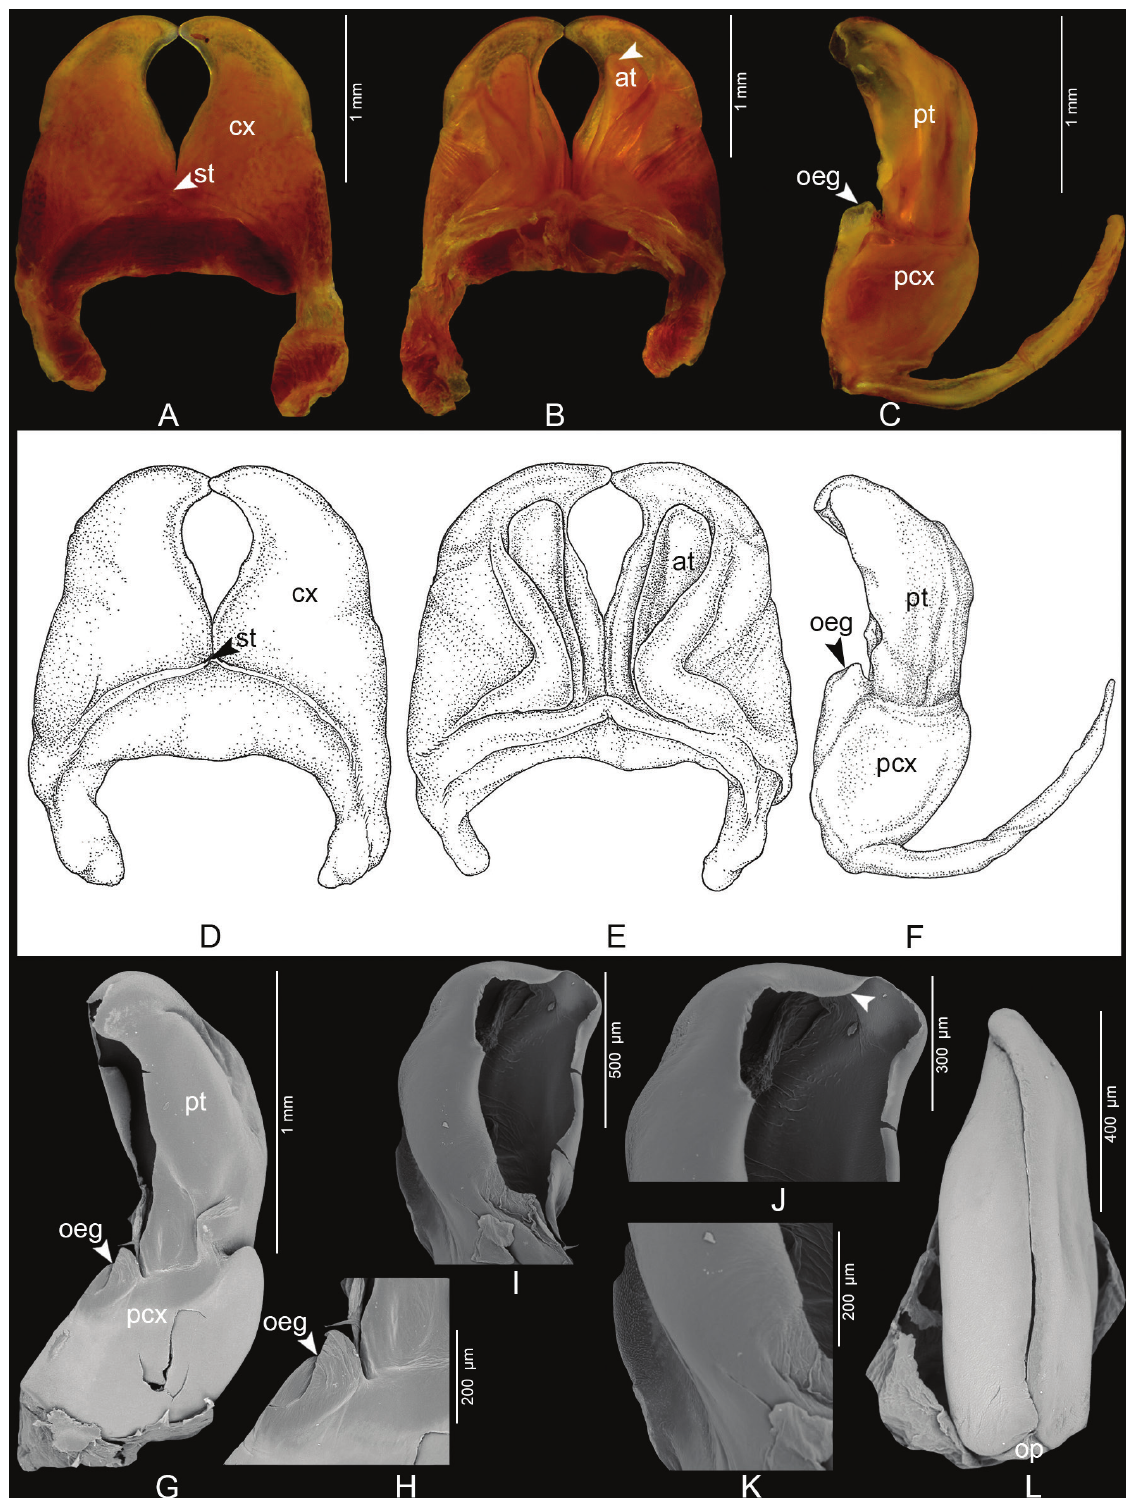
Figure 3. Siliquobolellus amicusdraconis gen. et sp. nov., holotype, gonopods (specimen from Hub Pa Tard, CUMZ-D00149-1). A. Anterior gonopod, anterior view; B. Anterior gonopod, posterior view, arrow indicates a thumb-like process; C. Right posterior gonopod, lateral view; D. Anterior gonopod, anterior view; E. Anterior gonopod, posterior view; F. Right posterior gonopod, lateral view; G. SEM, Right posterior gonopod, latero-mesal view; H. SEM, Mesal part of right posterior gonopod, lateral view; I. SEM, Right posterior gonopod, latero-mesal view; J. SEM, Tip of right posterior gonopod, latero-mesal view, arrow indicates a canopy; K. SEM, lateral part of pt, latero-mesal view; L. SEM, left female vulva, posterior mesal view. at = anterior gonopod telopodite; cx = coxa; oeg = opening of efferent groove; op = operculum of vulva; pcx = coxal part of the posterior gonopod telopodite; pt = telopodital part of the posterior gonopod telopodite; st = sternal